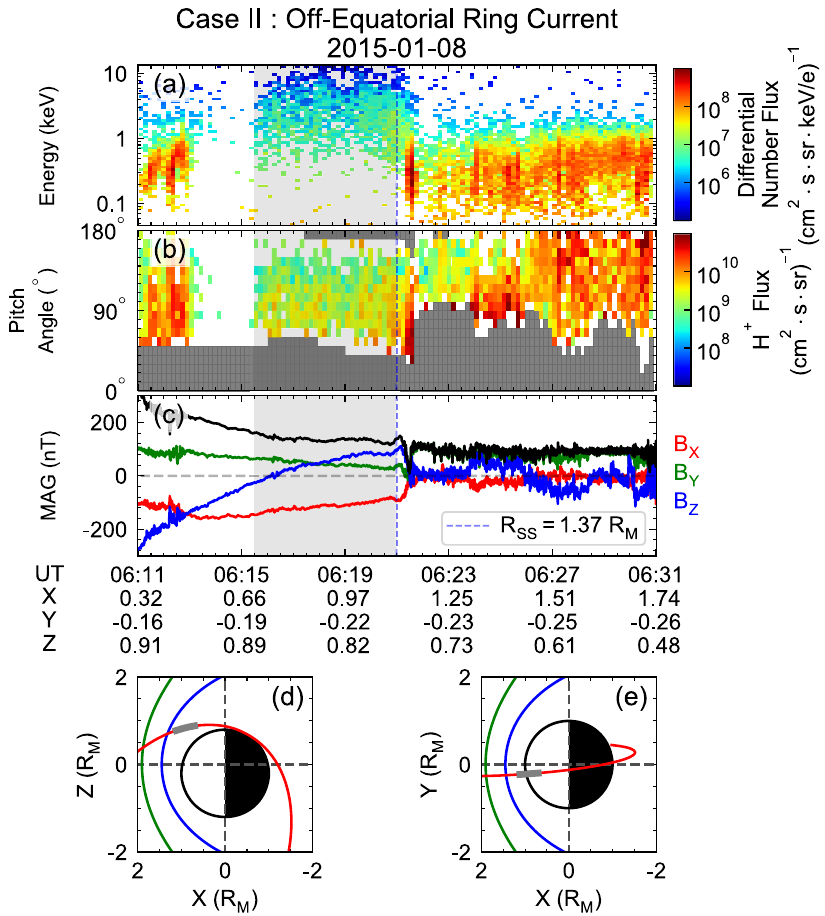
Fig. 2 MESSENGER observations during dayside magnetosphere crossing with potential off-equatorial ring current on Jan 8 th , 2015. a Energy spectrum of the protons. b Corresponding pitch angle distribution, with uncovered pitch angle bins noted by grey grids. c Components of the magnetic fi eld (red, green, and blue solid lines represent the B x ; B y and B z components, respectively) and strength (solid black line). d , e the trajectory of MESSENGER in XZ, XY planes. The thick shaded areas in a – c indicate the time periods during which FIPS observed trapped energetic protons. The corresponding spacecraft locations during these intervals are plotted in d – e as bold grey lines, and the green and blue curves show the modelled dayside bow shock and magnetopause that is obtained from the statistical distribution of observed crossing points 12 , respectively. The white and black half-circles represent the dayside and nightside hemisphere of Mercury, respectively. See Supplementary Fig. 8 for the colour alternative version of this fi